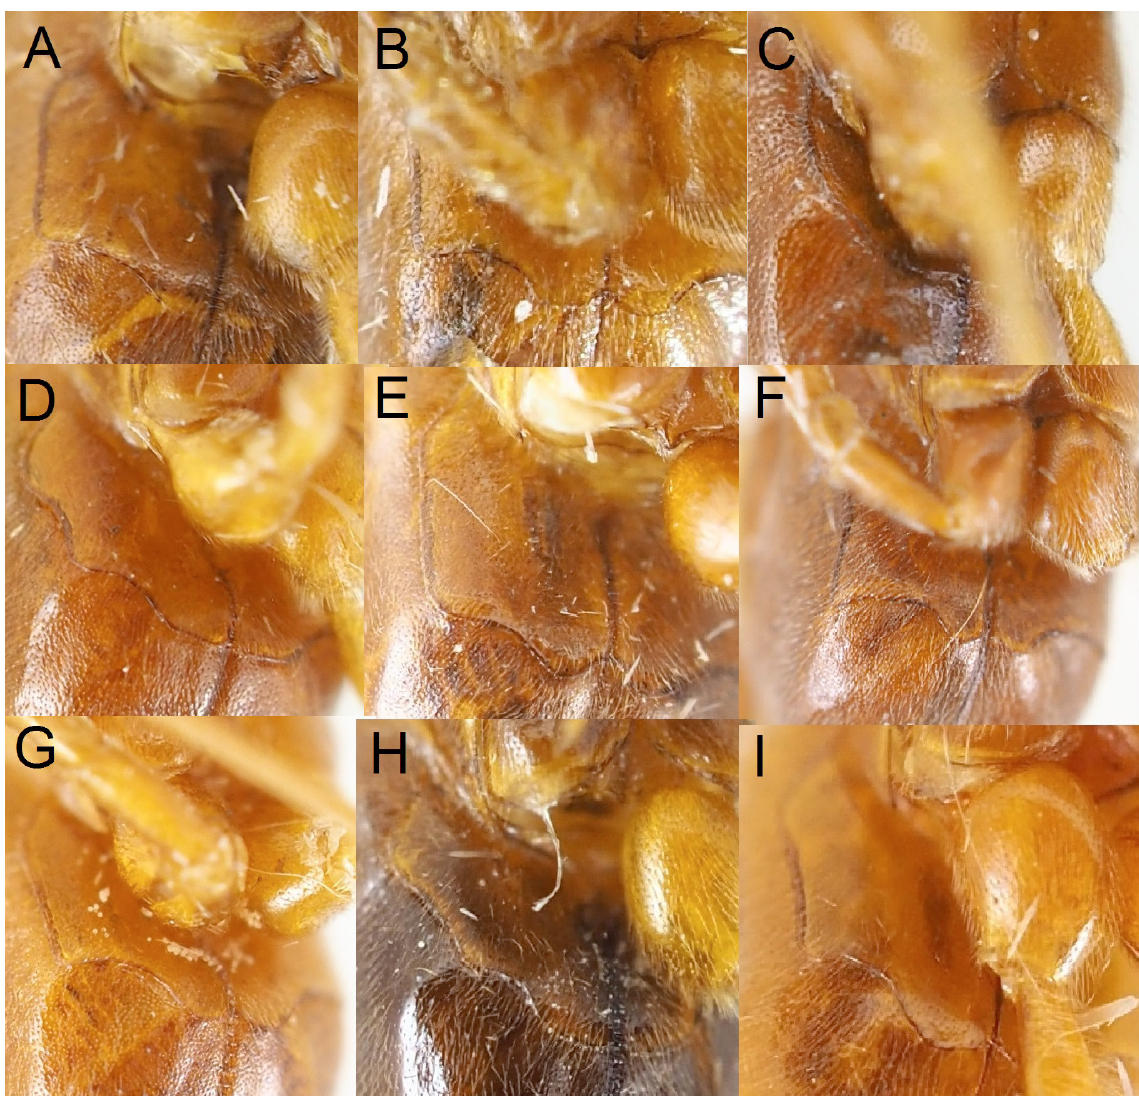
Fig. 9 . Epicnemial carina, antero-ventral view of female. A . Ophion splendens Johansson sp. nov., paratype, ♀ (NHRS-HEVA000008708). B . O. mocsaryi Brauns, 1889. C . O. dispar Brauns,